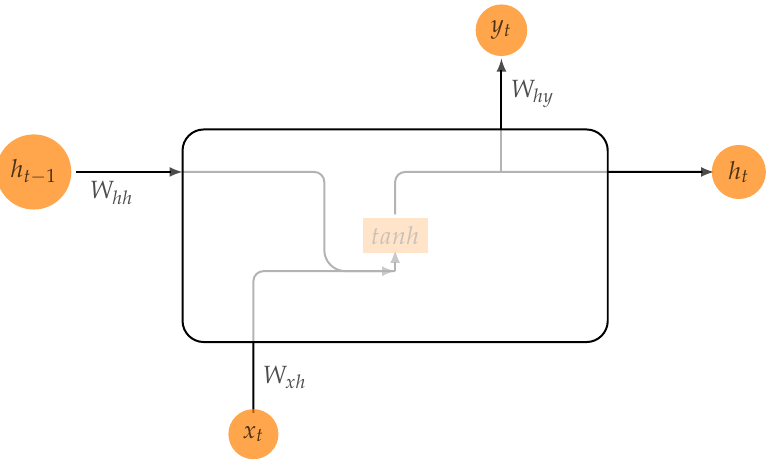
Figure 1. Structure of recurrent neural network